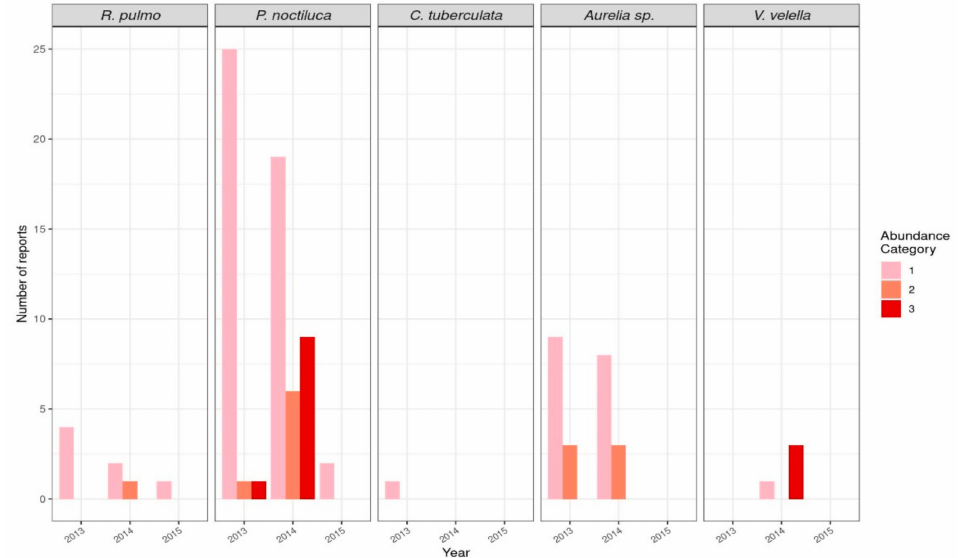
Figure 5. Total number of jellyfish reports from 2013 to 2015 for Tunisia. Each sector represents a different species, and the color scale represents different abundance categories (darker colors meaning higher